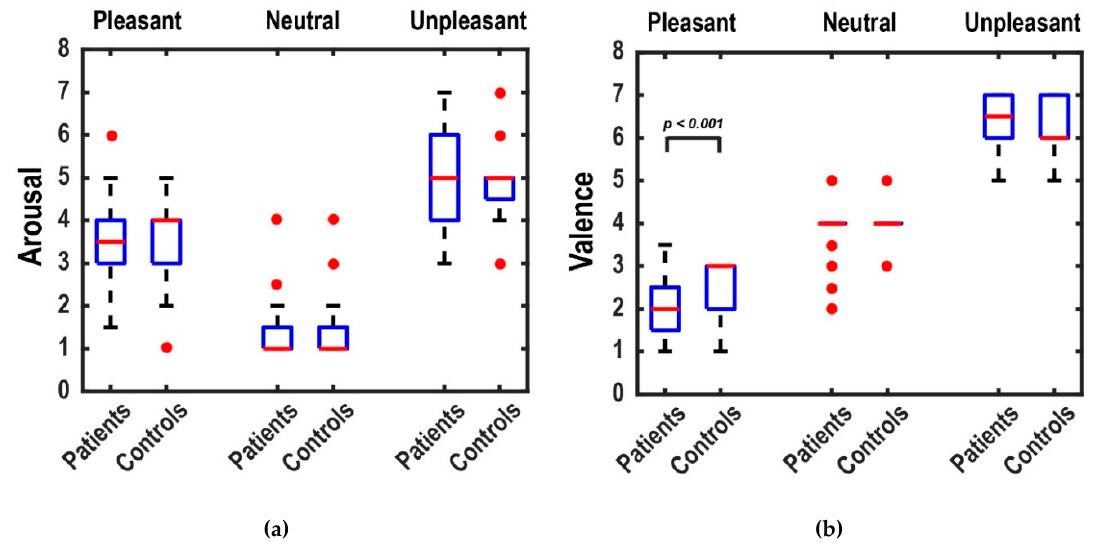
Figure 3. Boxplots of the arousal ( a ) and valence ( b ) ratings of patients and healthy controls for each picture category. Boxplots show the median ratings of subjects for each picture category. The red lines are the medians, and the red circles represent outliers. The valence ratings for pleasant stimuli are significantly higher for healthy controls compared to patients.